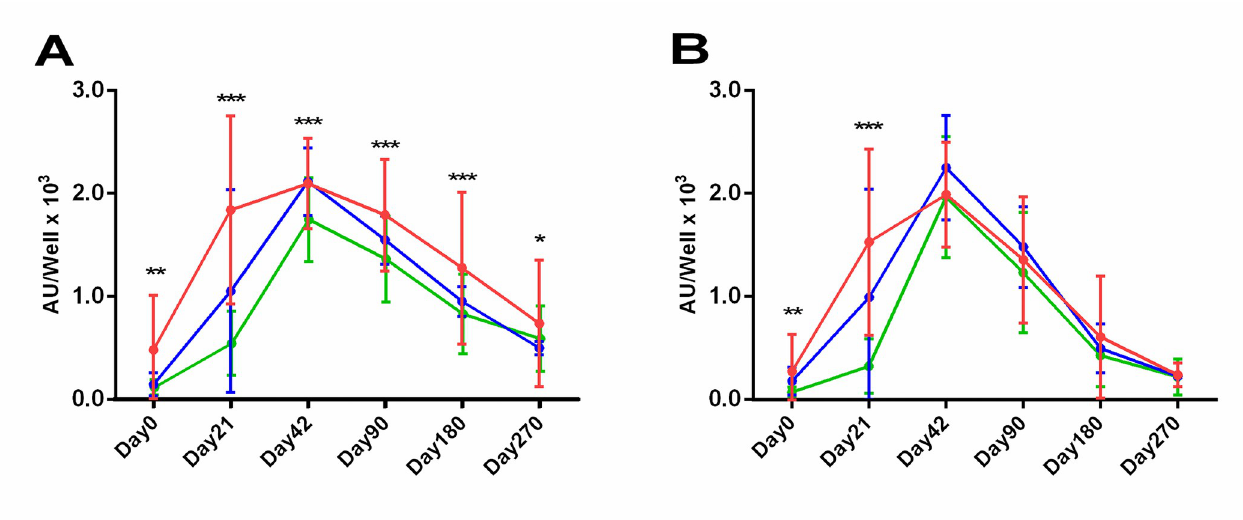
Fig 6. IgG anti-S and anti-RBD kinetics in a 9-month period: PCR+ individuals (red, n = 12 COVID-19), na ï ve individuals (green, n = 131) and suspected COVID-19 asymptomatic individuals (blue, n = 3). IgG anti-S (A) and anti-RBD (B) Abs were measured on Day0, 21, 42, 90, 180 and 270 days after the first dose. For each group, mean and standard deviation values are given for every time-point. Asterisks ( � ) indicate statistically significant differences ( p -value: � < 0.05, �� < 0.001, ��� 0.001) between the groups of PCR+ and na ï ve